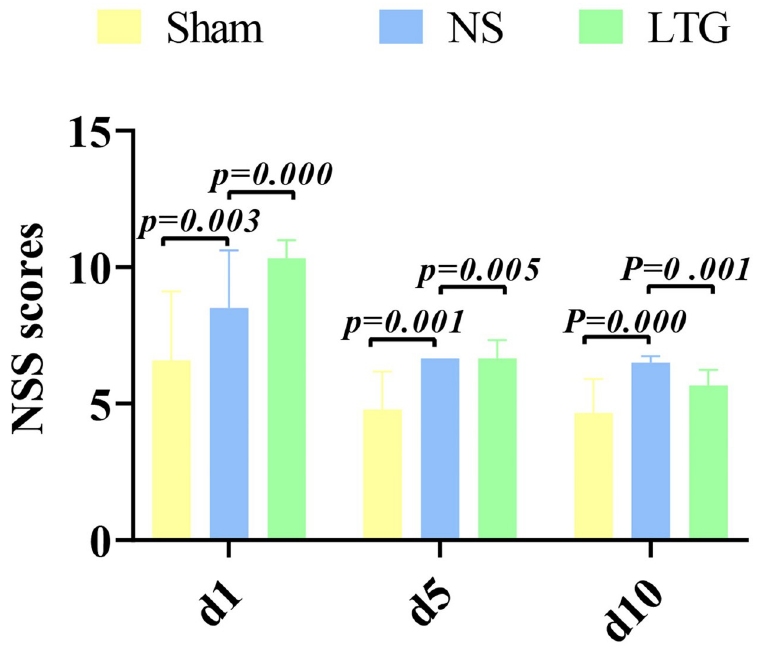
Fig 6. Histogram of modified mNSS score. Note: the abscissa is the postoperative days (d), and the ordinate is the improved Nss score.